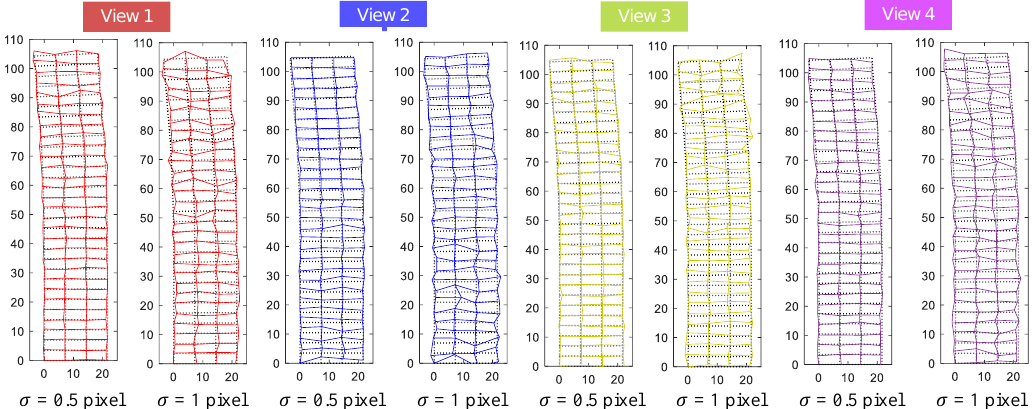
Figure 10. Rectified images from each view with different noise levels (Building deformations are drawn to a scale of ten only for enhanced